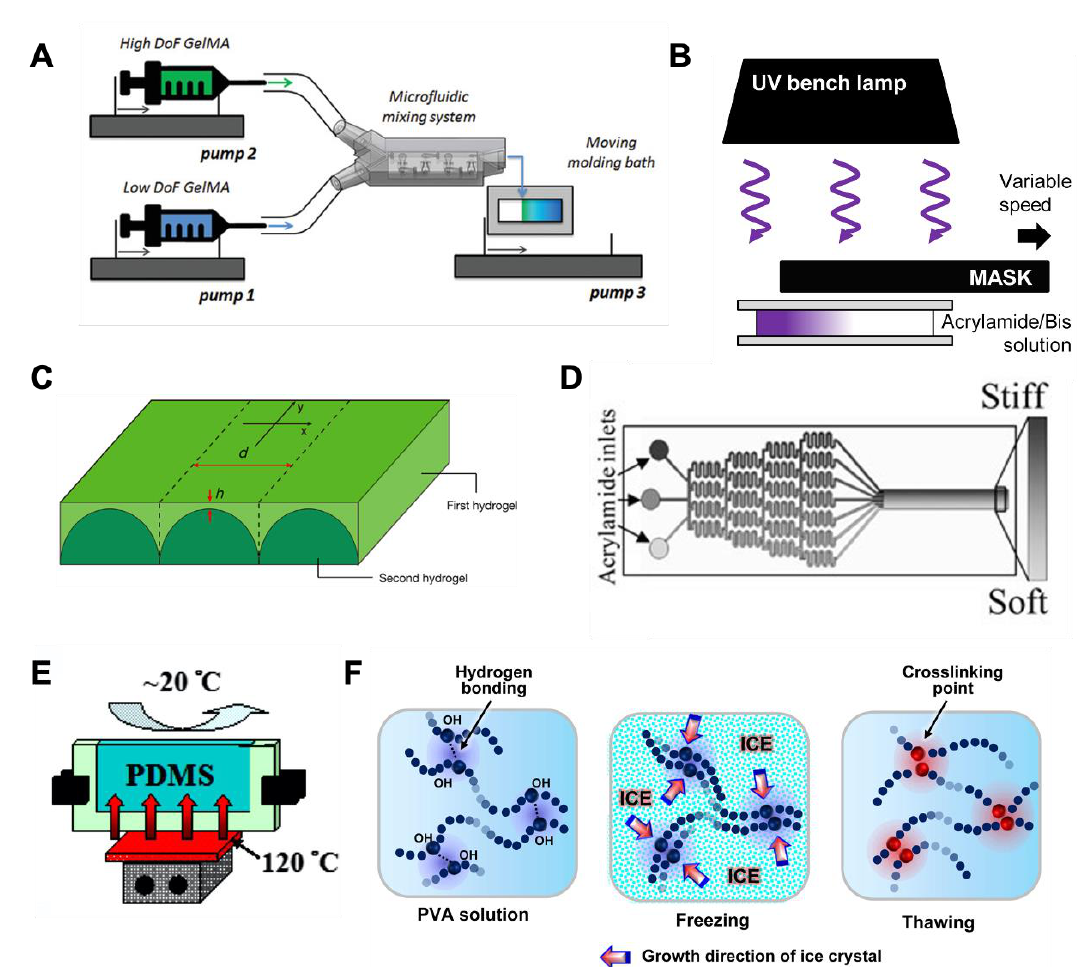
Figure 2. Hybrid and synthetic hydrogels used for creating stiffness gradient. ( A ) Gradient generation by syringe pumps. Reprinted with permission from [110]. ( B ) A moving photomask to create different degrees of photopolymerization. Reprinted with permission from [125]. ( C ) Microstructured hydrogel layer (bottom) and superficial gel layer (top) to create a mechanical interface with different stiffness levels. Reprinted with permission from [91]. ( D ) Microfluidic-based gradient generator was used for creating a gradient of bis-acrylamide that led to a gradient of crosslinking density upon UV irradiation. Reprinted with permission from [95]. ( E ) PDMS was cured with a temperature gradient, leading to a gradient of crosslinking. Reprinted with permission from [114]. ( F ) PVA was repeatedly dipped into liquid nitrogen to induce a gradient of physical crosslinking. Reprinted with permission from [115].